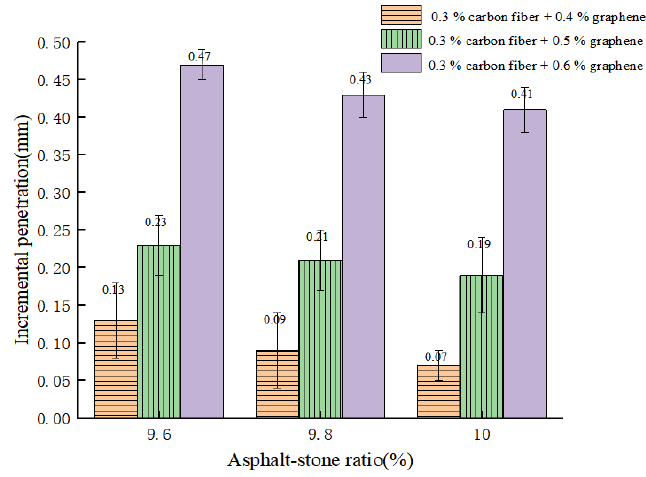
Figure 14. Test results of penetration increment with different oil–stone ratio.